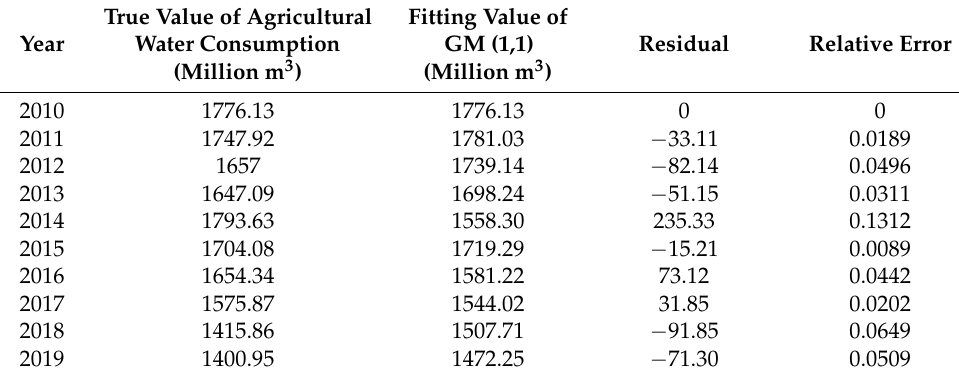
Table 6. Fitting results of agricultural water demand prediction model in Changsha city from 2010 to 2019.